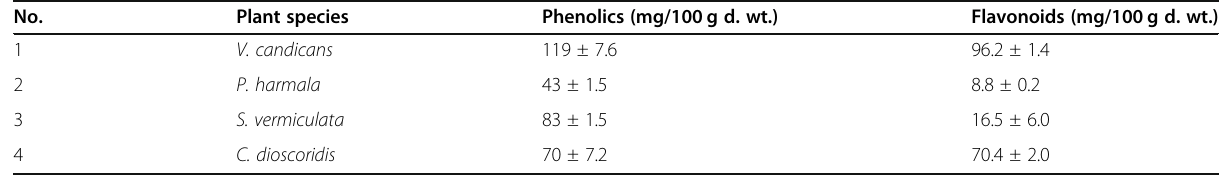
Table 3 Total phenolics and flavonoids in the ethanolic extracts of four Egyptian wild plant species. Data are expressed as mean ± SD No. Plant species Phenolics (mg/100 g d. wt.) Flavonoids (mg/100 g d.